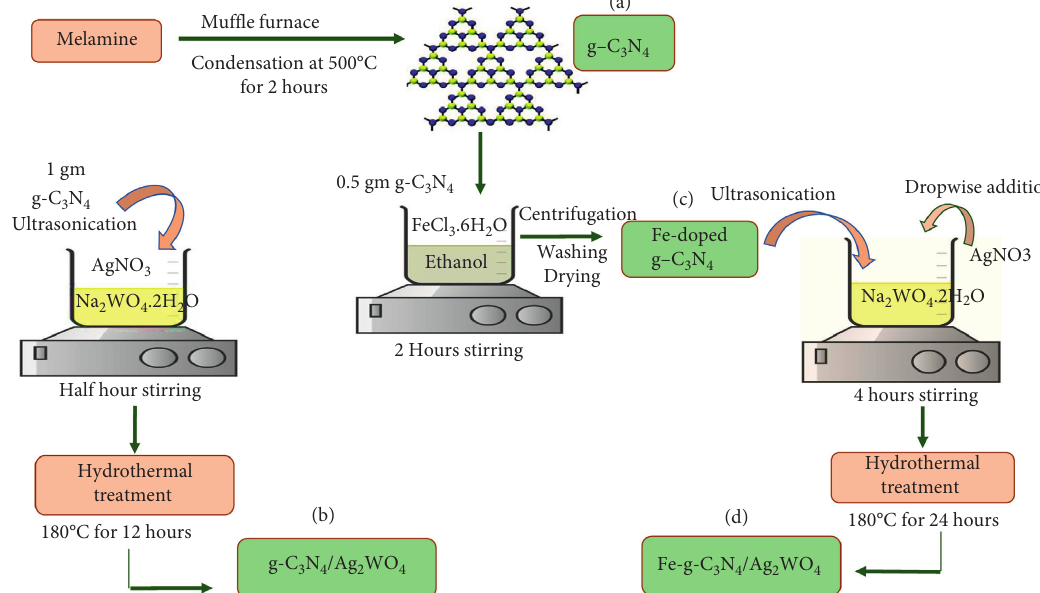
Figure 1: Schematic illustration of (a) g-C 3 N 4 , (b) g-C 3 N 4 -Ag 2 WO 4 , (c) Fe-g-C 3 N 4 , and (d) Fe-g-C 3 N 4 /Ag 2 WO 4